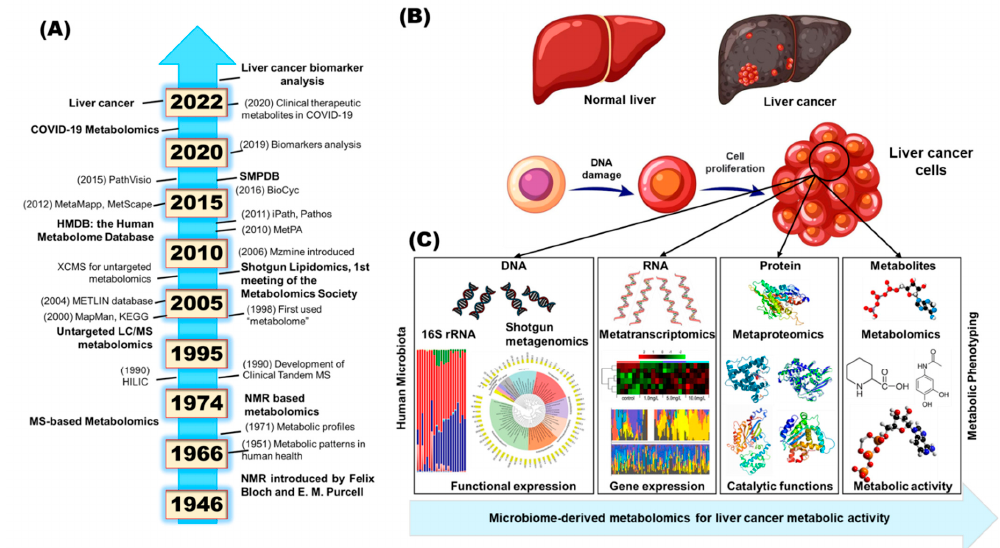
Figure 1. ( A ) The long history of metabolomics; timeline of major research and development mile ‐ stones related to metabolomics and their medical applications. ( B ) Normal liver and liver cancer cells. ( C ) A schematic representation showing the multiomics cascade of systems biology. The mul ‐ tiomics analysis is influenced by epigenetics, toxicity, disease, and other environmental exposures. Here, metabolic communication within cells is carried out by DNA (metagenomics), RNA (meta ‐ transcriptomics), protein (metaproteomics), and metabolites (metabolomics). In Figure 1B, and 1C, the guiding principles of genomics, transcriptomics, prote ‐ omics, and metabolomics are listed with targeted and untargeted profiling methods, each with their own benefits and limitations [21–23]. Untargeted metabolomics is focused on the examination of recognizable metabolites and/or metabolomes in biological mixtures, including unknown chemicals. The metabolome is the set of metabolites within a given cell. Metabolome concentrations are widely connected with phenotypic expression [17,24].